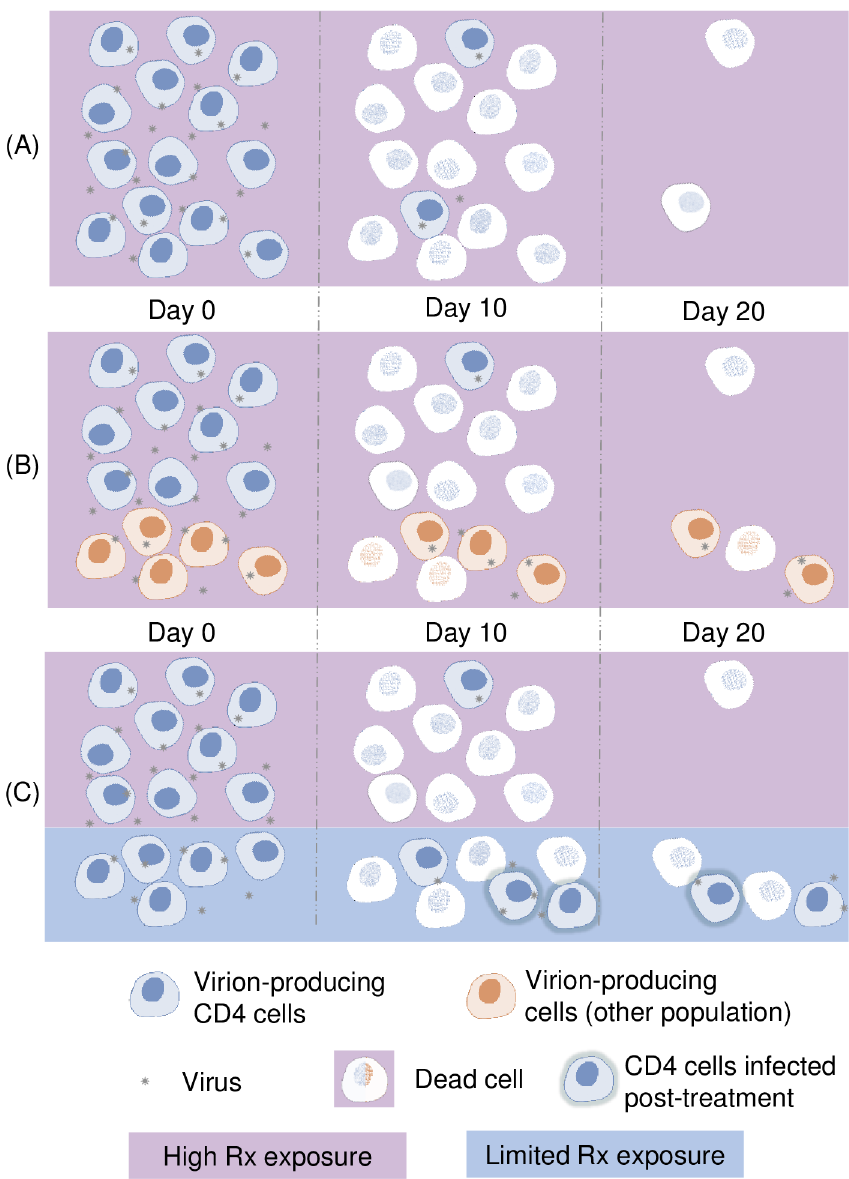
Fig 1. Hypotheses related to the decay of virion-producing cells after treatment initiation. A) Virion-producing cells are short-lived infected CD4 cells and all new cell infections are prevented due to high drug exposure. This translates into only one phase of viral decay; B) There are two types of virion-producing cells having half-lives of around 1 (short-lived) and 14 days (long-lived), respectively, and all new cell infections are prevented due to high drug exposure.[1] This translated into two phases of viral decay C) Virion-producing cells are mostly short-lived infected CD4 cells located in two compartments, one with high (pink) and one with low (blue) drug exposure. The compartment with low drug exposure partially allows new cell infections, effectively leading to two phases of viral decay. The compartment is not associated to a specific tissue at this point, as its existence is hypothesized.